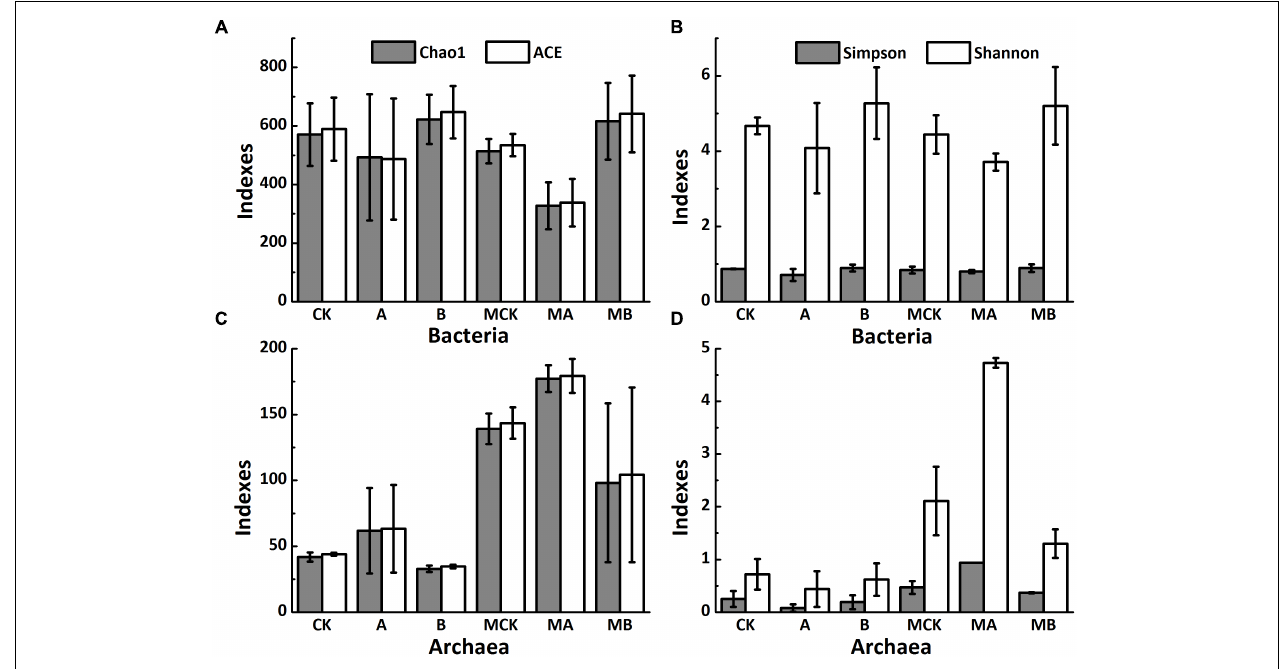
FIGURE 2 | Alpha diversity indexes of soil bacteria (A,B) and archaea (C,D) of different treatments. Abbreviations of the treatments are as Figure 1 .